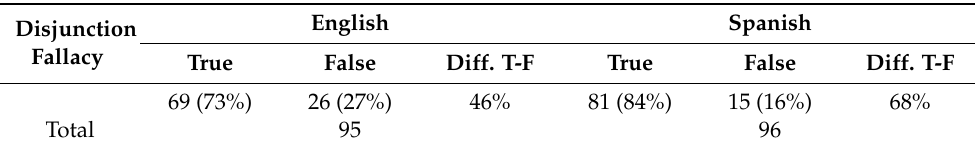
Table 14. Disjunction fallacy results (total number of true and false responses and percentages per language).